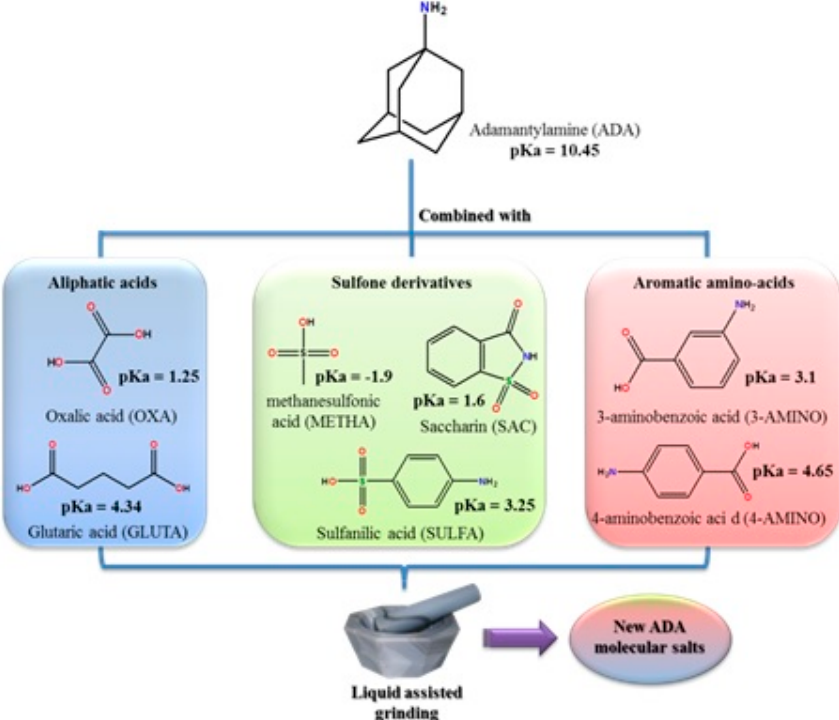
Figure 12. General experimental conditions and products obtained in the reactions between adamantylamine and aliphatic acids, sulfone derivatives, and aromatic acids